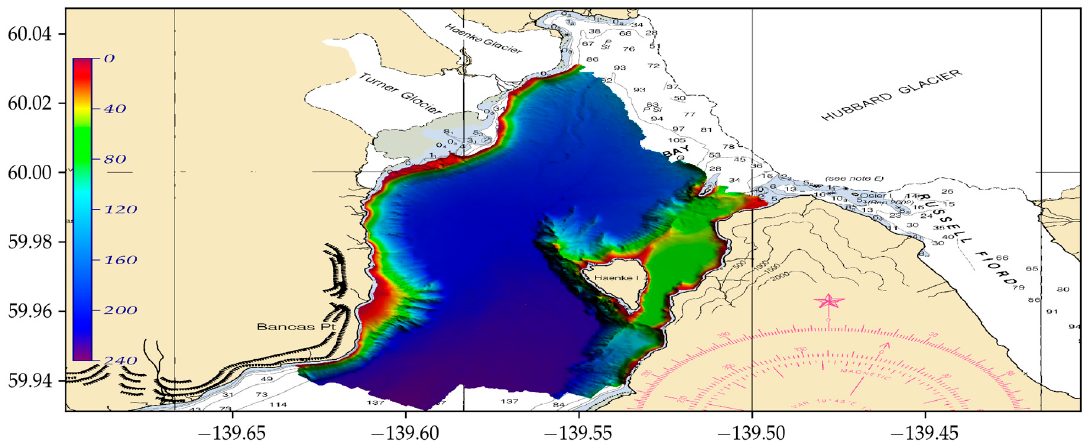
Figure 10. Bathymetric model generated using the data collected by the NOAA H13071 survey. The NOAA raster nautical charts 16761 (Yakutat Bay) is shown in the background. Bathymetric values in the color bar (in blue) are in meters and referred to the Mean Lower Low Water (MLLW) vertical datum. Axes in geographical WGS84 coordinates.